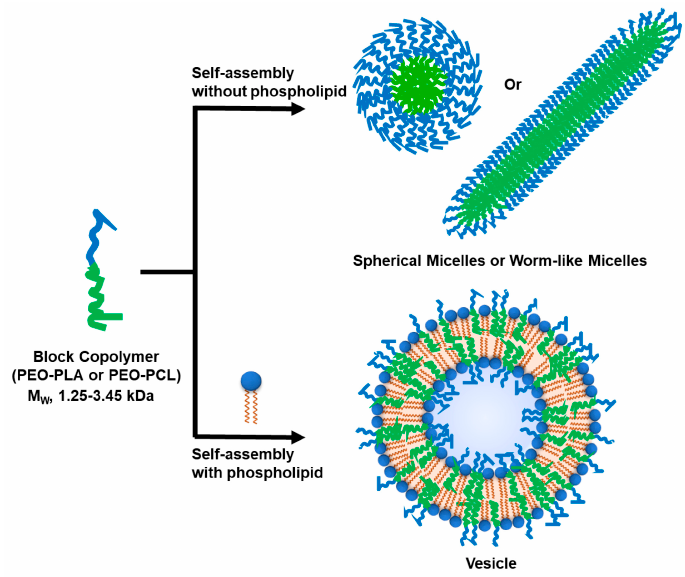
Figure 5. Self-assembly of low-molecular-weight block copolymers, as PEO-PCL in the absence and presence of phospholipid. Adapted by Khan et al. [75].